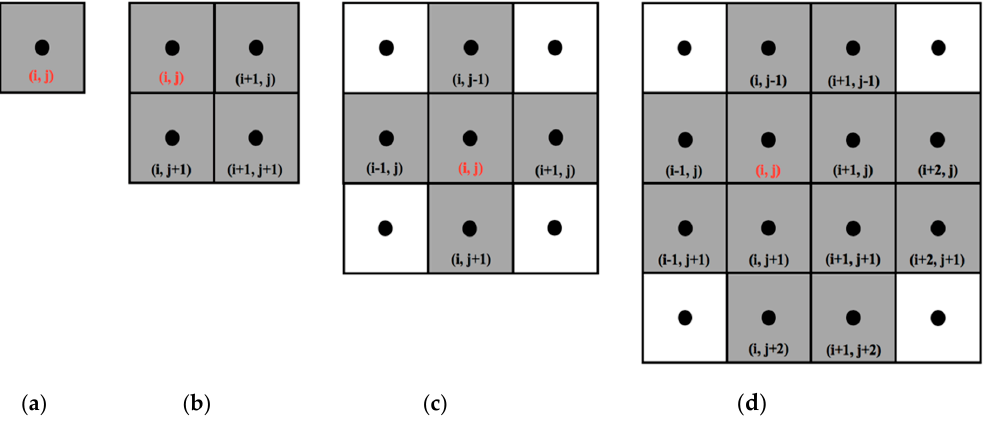
Figure 2. Shapes of the constructed viewing areas with diameters of ( a ) 2.75, ( b ) 5.5, ( c ) 8.25, and ( d ) 11 km. The dots represent the center of a respective grid with the red text outlining the starting grid upon which steps were applied in the i and j directions to complete the relevant